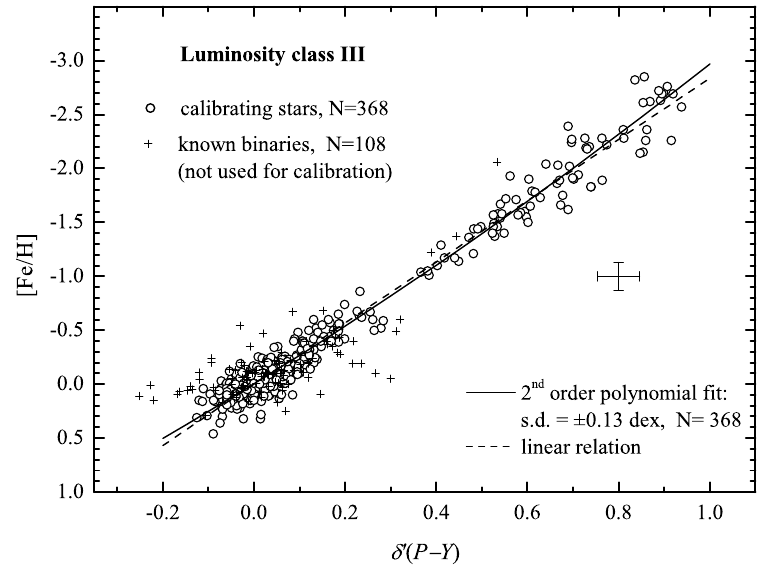
Fig. 7b. (cid:14) ′ ( P – Y ) vs. [Fe/H] relation for giant stars with metallicities from high- dispersion